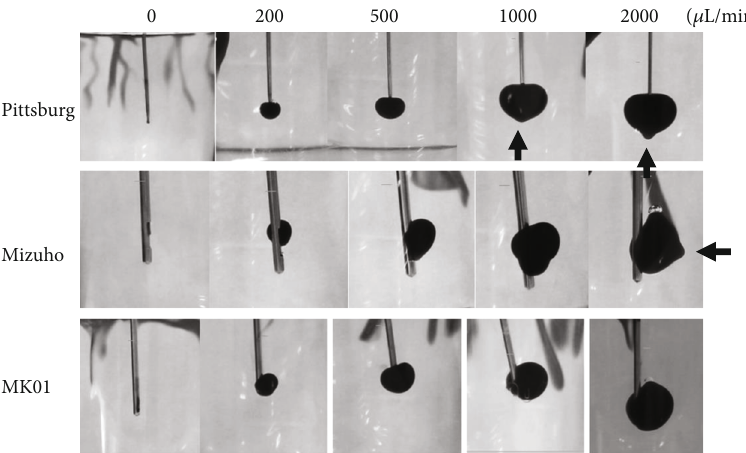
Figure 5: Colored saline injected in the gel imitating the brain. The Pittsburg and Mizuho needles showed jet fl ow prominence (arrow) at 2000 μ L/min (arrow), while MK01 did not cause